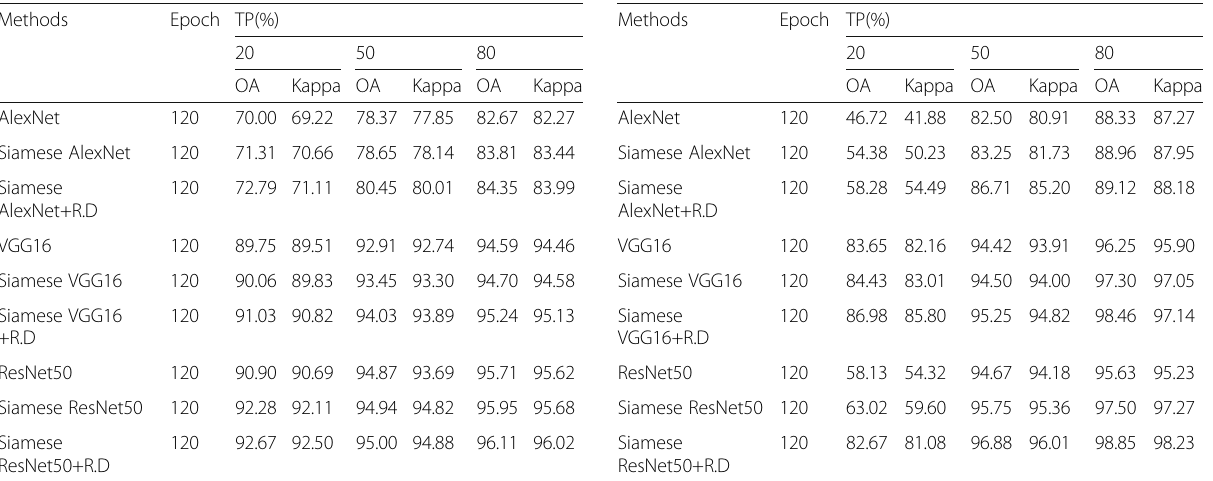
Table 4 Comparison of OA (%) and Kappa (%) on SIRI-WHU data